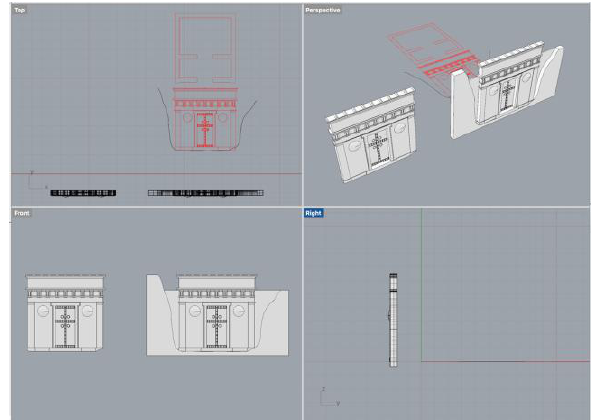
Figure 22. The Tomb of Alexander IV at Verghina. Construction of the 3D model.